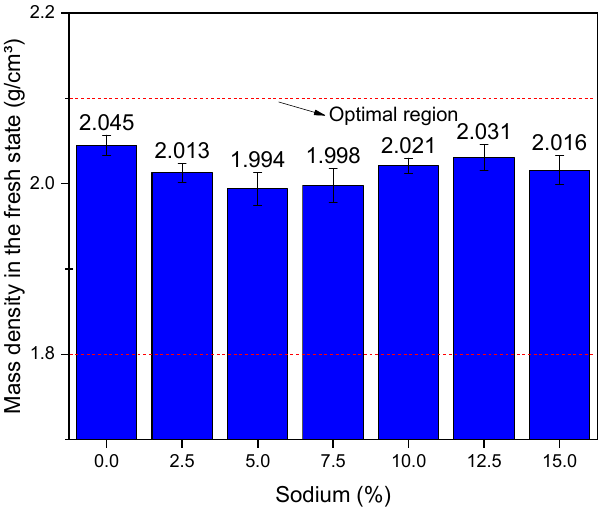
Figure 5. Results of mass density in the fresh state as function of the sodium content.